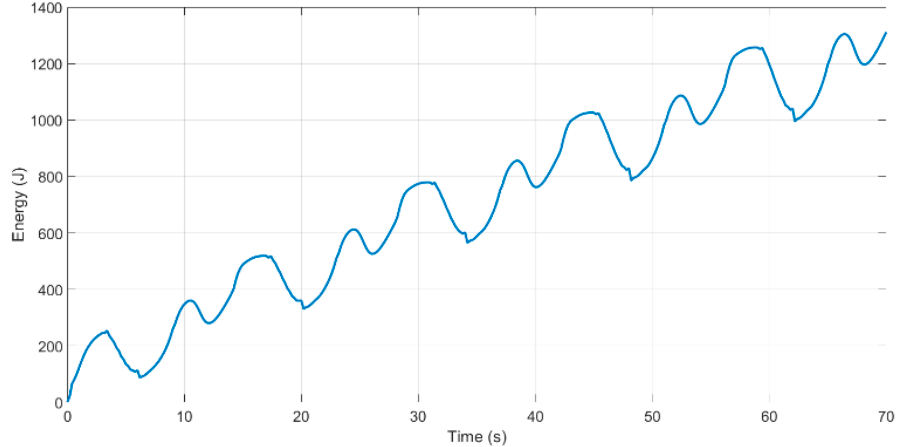
Figure 17. The energy change calculated by the energy harvesting mechanism.